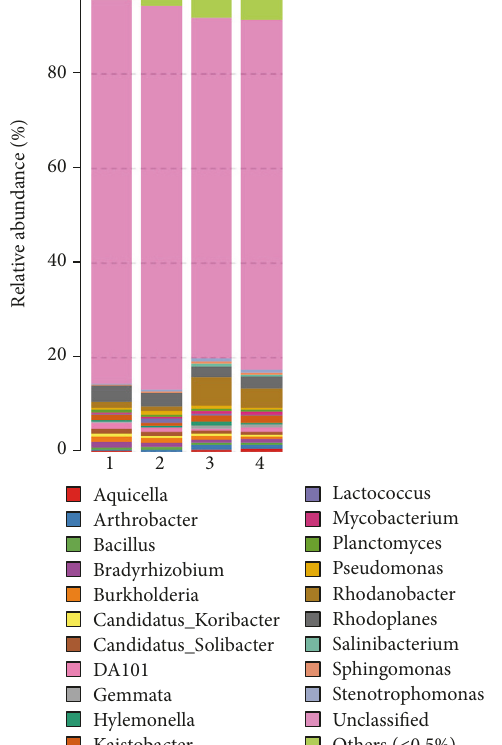
Figure 1: Relative abundance of bacterial genera. Samples 1 and 2 represent the two replicates of relatively unhealthy soil samples, while Samples 3 and 4 represent the two replicates of relatively healthy soil samples.